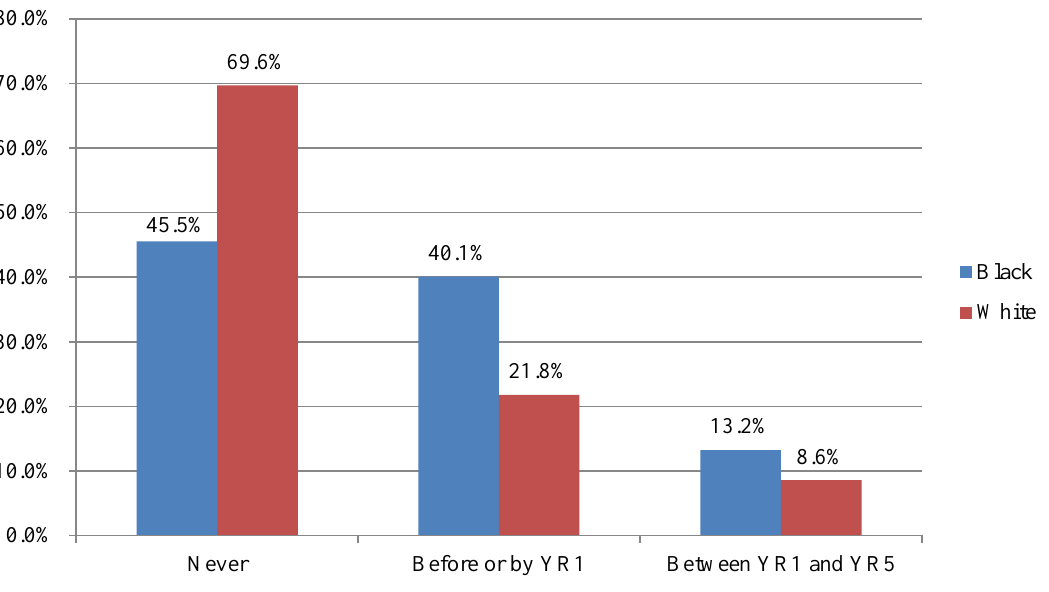
Figure 2: Exposure to Paternal Incarceration in the Fragile Families Study by Year 5 by Race (in